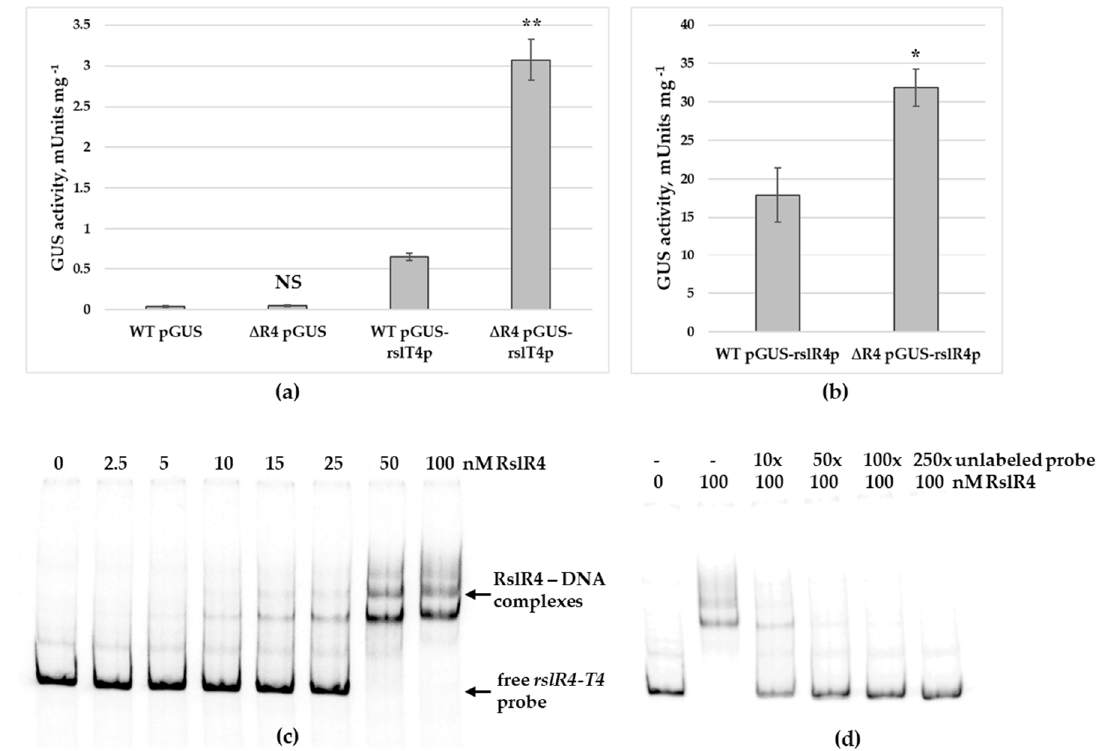
Figure 5. RslR4 negatively regulates transcription of rslT4 and rslR4 genes. ( a ) Transcriptional activity of rslT4 promoter in S. bottropensis and in S. bottropensis ∆ R4. ( b ) Transcriptional activity of rslR4 promoter in S. bottropensis and in S. bottropensis ∆ R4. Cultures and subsequent β -glucuronidase measurements were done in triplicate. Values were normalized to equal amounts of dry biomass. Error bars represent standard deviations. Significant differences in β -glucuronidase between S. bottropensis and S. bottropensis ∆ R4 were calculated by a two-tailed t -test. Asterisks represent the significance value (* p < 0.05, ** p < 0.01), whereas NS refers to not-significant differences. ( c ) Electrophoretic mobility shift assay to study interaction of RslR4 with rslR4-T4 region. Increasing concentrations of RslR4 were mixed with labeled rslR4-T4 DNA probe. ( d ) Competition assay of RslR4 (100 nM) with rslR4-T4 region carrying 10-, 50-, 100- and 250-fold excess of unlabeled probe.